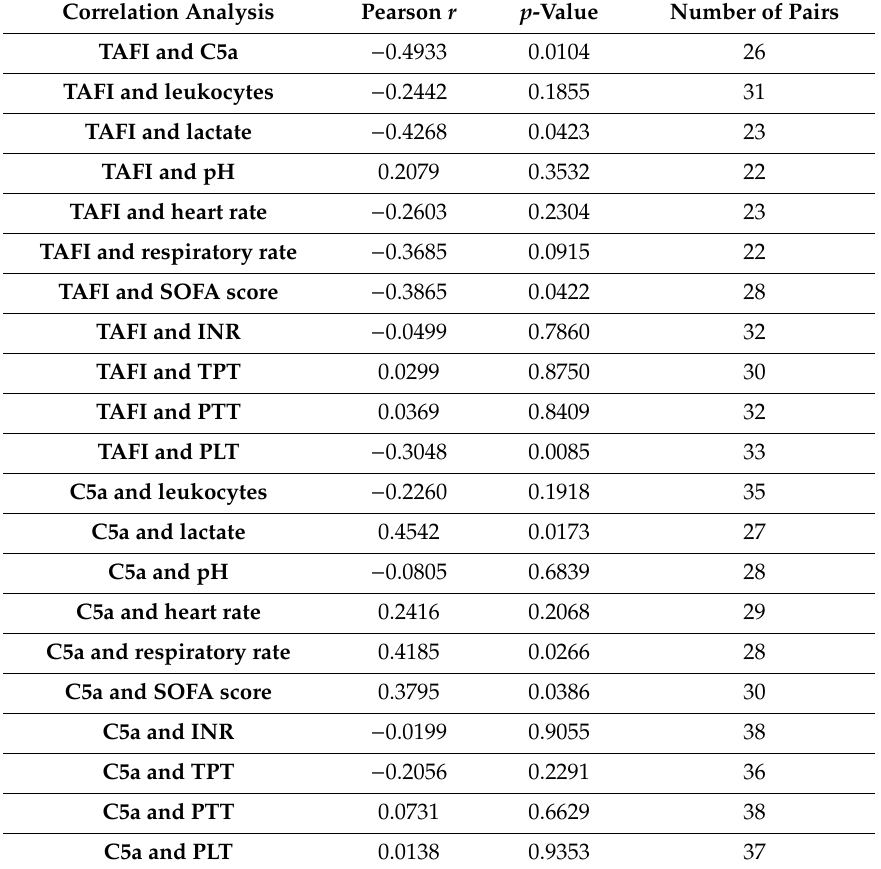
Table 4. Correlation analyses between thrombin-activatable fibrinolysis inhibitor (TAFI), C5a, leukocyte counts, lactate levels, pH values, heart and respiratory rates, sequential (sepsis-related) organ failure assessment (SOFA) score, international normalized ratio (INR), thromboplastin time (TPT), partial thromboplastin time (PTT), and platelet (PLT). p < 0.05: statistically significant. Correlation Analysis Pearson r p